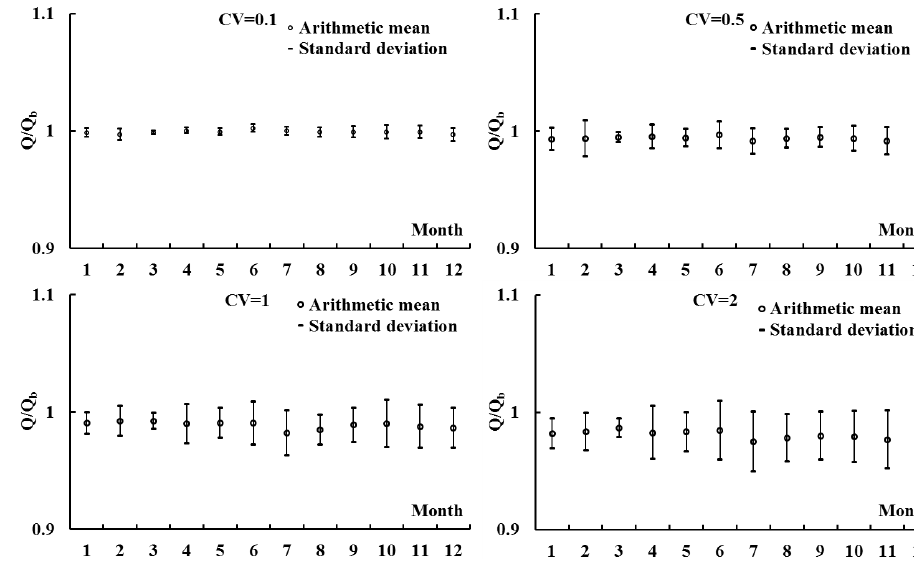
Figure 6. Means and confidence intervals of stream–aquifer leakage from local